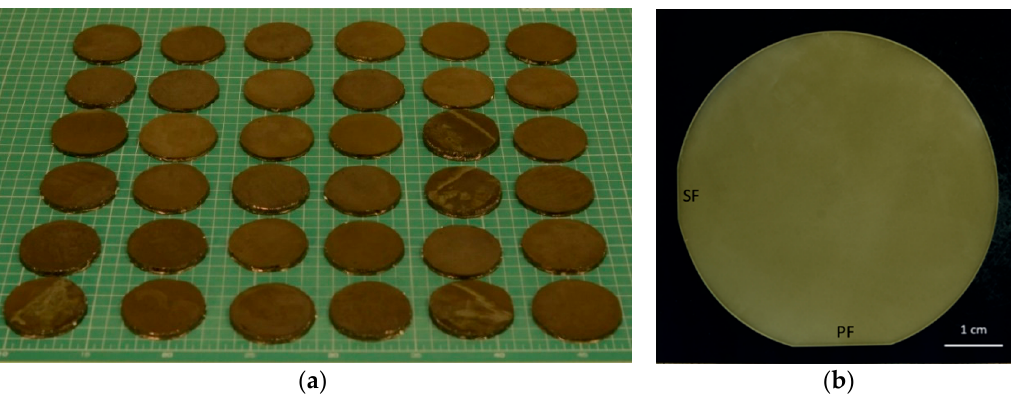
Figure 7. ( a ) Am-GaN as-grown crystals from one crystal growth process; grid 1 mm; ( b ) 2-inch ammonothermal GaN substrate; primary flat (PF) and secondary flat (SF) are marked.